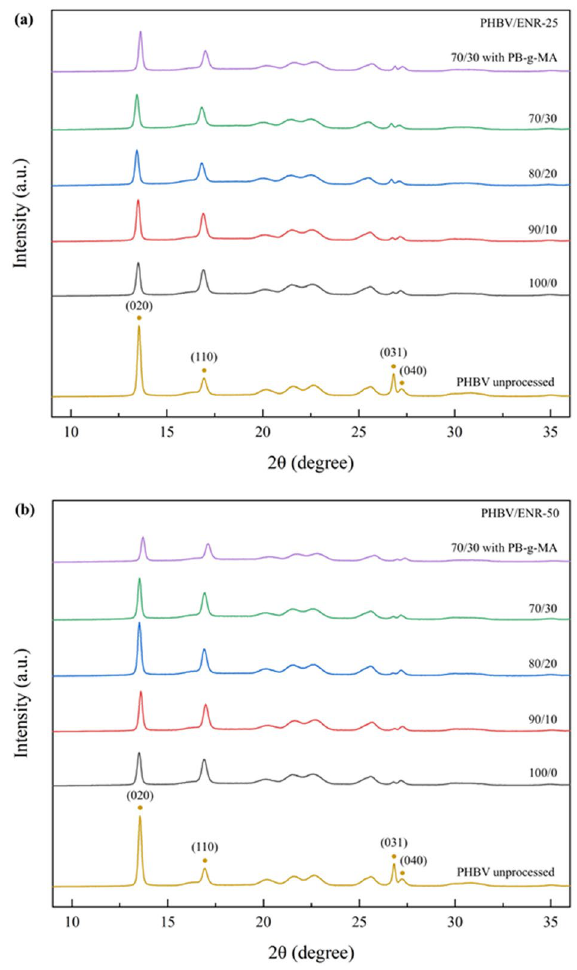
Figure 4. XRD diffractograms of the neat PHBV (PHBV unprocessed) and PHBV/ENR blends ( a ) PHBV/ ENR-25 blends and ( b ) PHBV/ENR-50 blends.